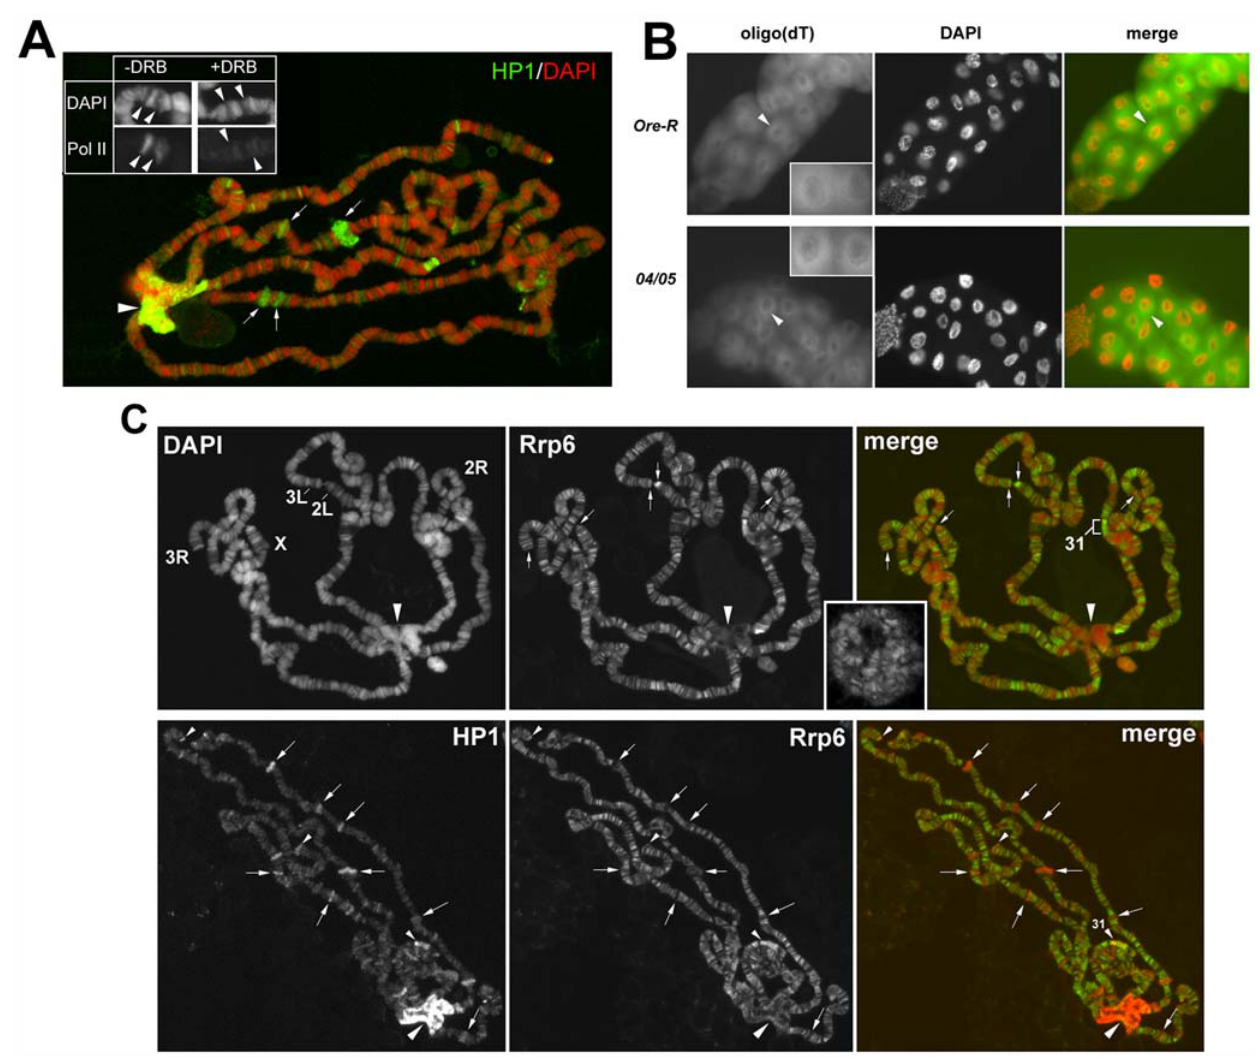
Figure 8. HP1a does not seem to be involved in transcript elongation, RNA export, or RNA surveillance. (A) Wild type heat-shocked polytene chromosomes treated with DRB. The treatment does not affect HP1a binding to the induced puffs (see arrows for examples). The absence of immunosignals in the insert shows that DRB does affects the Pol II Phospho Ser2 binding to heat-shocked puffs (arrowheads). ( B) FISH detection of poly(A) + RNA by a Cy3-labeled oligo(dT) probe in salivary glands from wild type and Su(var)2–5 04 /Su(var)2–5 05 HP1a mutant larvae. The tissues of both types of larvae show similar patterns (arrowheads). (C) Top, in polytene chromosomes of wild type larvae, the immunolocalization of the nuclear exosome component Rrp6. Note that the protein is present on many euchromatic sites including telomeres (arrows) and region 31, but absent on the heterochromatic chromocenter (big arrowhead). In the insert, a confocal microscopy image shows similar Rrp6 immunopattern also in not squashed polytenes. Bottom, the simultaneous immunolocalization of HP1a and Rrp6. Note that the two proteins colocalize mainly on telomeric regions and region 31 (small arrowheads); along the euchromatin there is little overlap (arrows indicate examples of regions that show positive HP1a and negative Rrp6